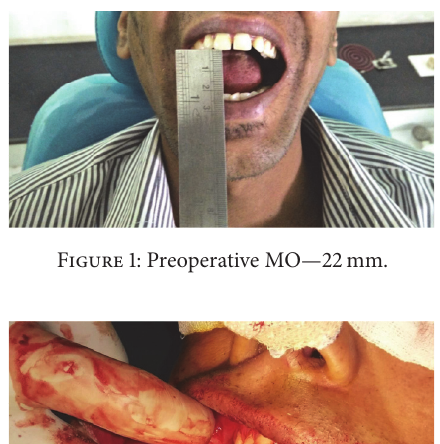
Figure 3: Collagen membrane impregnated with placental extract and hyaluronidase.